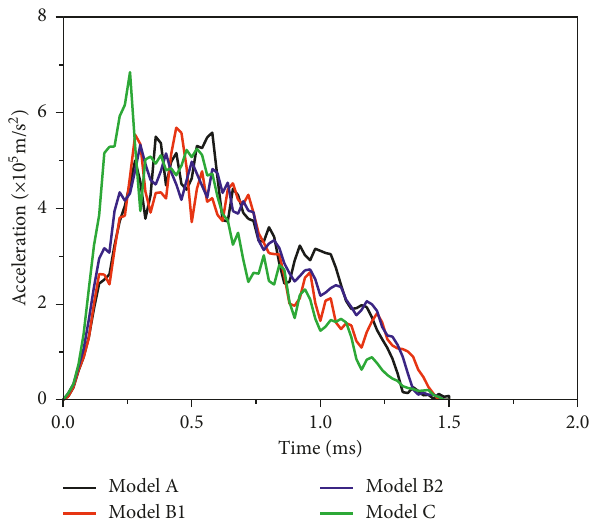
Figure 20: Acceleration curves of projectiles penetration FC-RPC target 3.